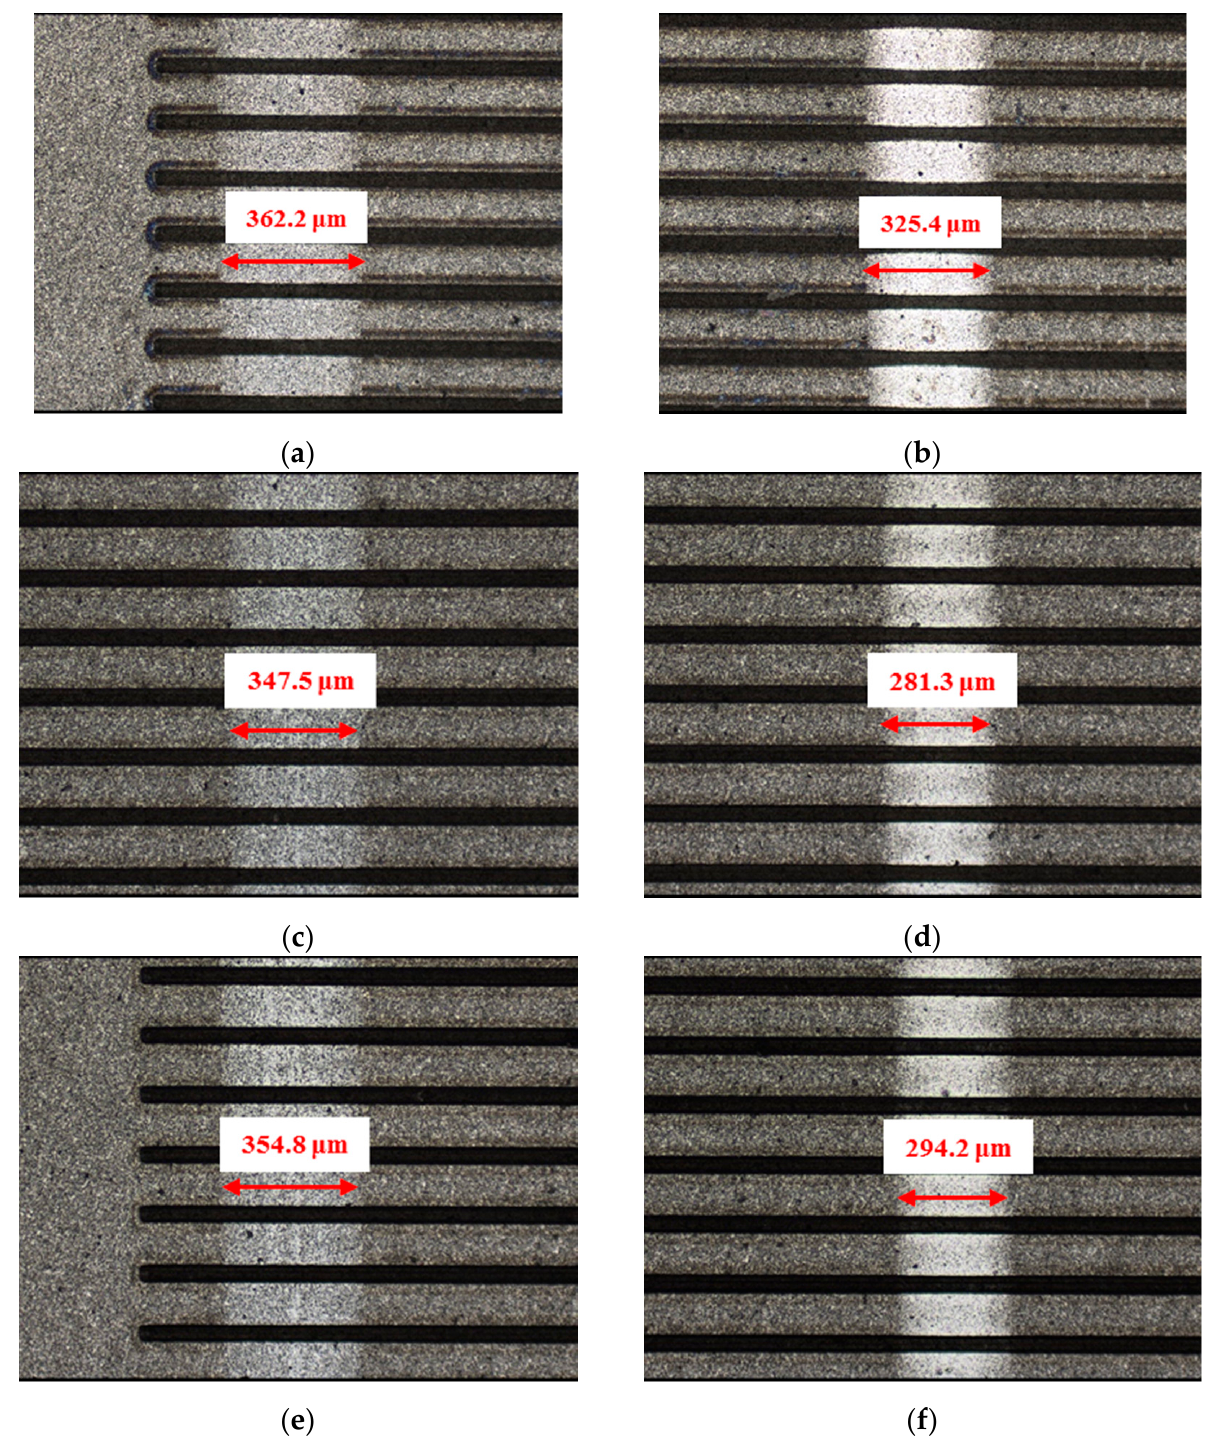
Figure 13. Wear performance of groove-textured SiC under oil-lubricated conditions with a load of 75 N ( × 10): ( a ) 3 µ m groove-textured SiC–steel ball, ( b ) 3 µ m groove-textured SiC–Si 3 N 4 ball, ( c ) 5 µ m groove-textured SiC–steel ball, ( d ) 5 µ m groove-textured SiC–Si 3 N 4 ball, ( e ) 10 µ m groove-textured SiC–steel ball, and ( f ) 10 µ m groove-textured SiC–Si 3 N 4